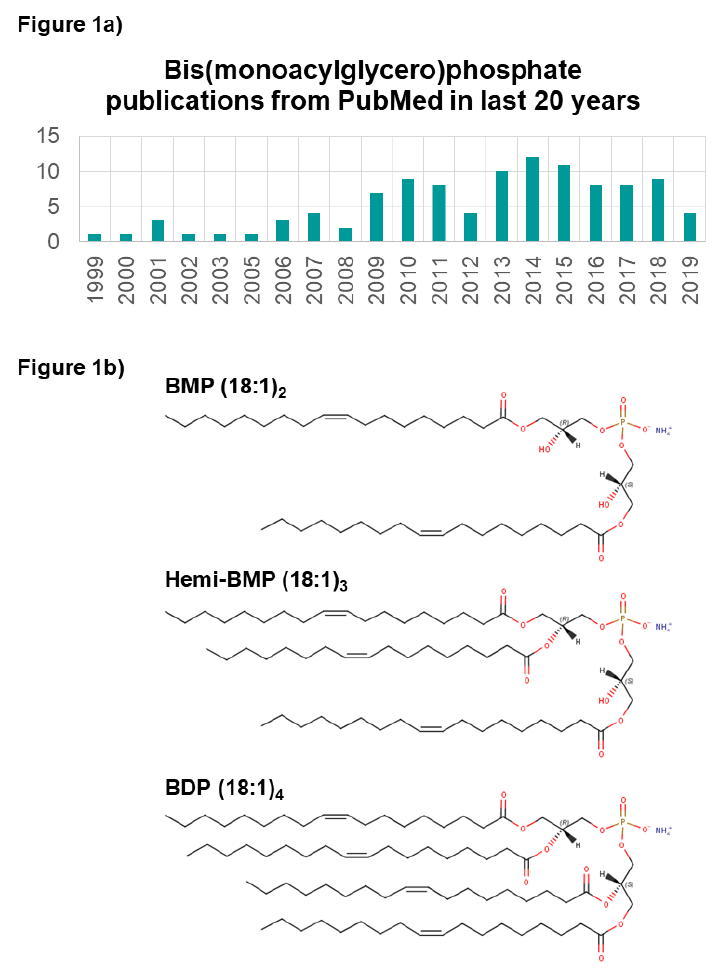
Figure 1. Overview of bis(monoacylglycero)phosphate (BMP) publications and known BMP species. ( a ) Number of publications mentioning BMP in PubMed from 1999 to 2019. ( b ) Known BMP species variants, shown with fatty acyl side chains composed of oleic acid (FA C18:1) as an example.